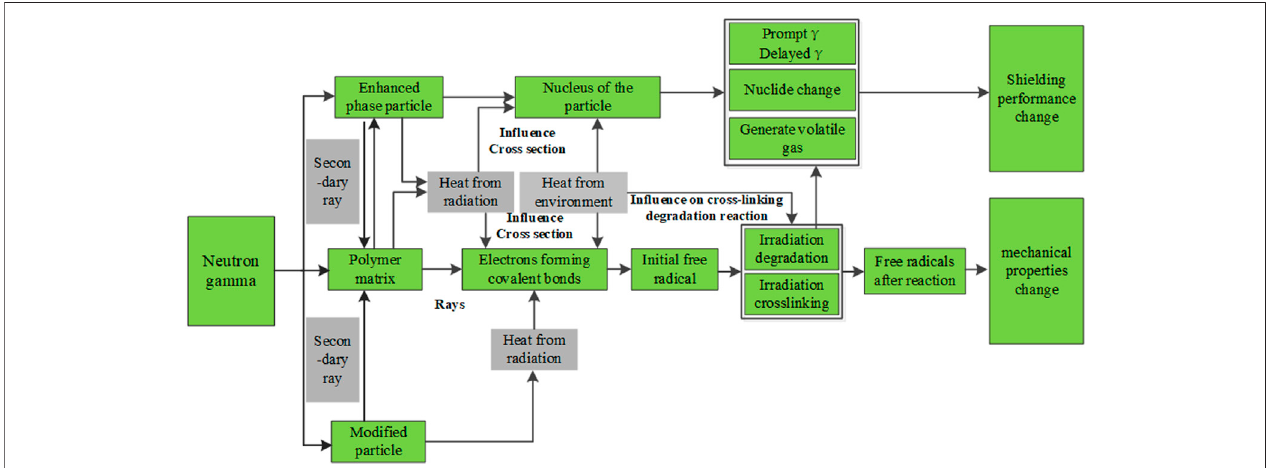
FIGURE 2 | Damage mechanism analysis of the materials under the synergy of nuclear radiation and temperature.